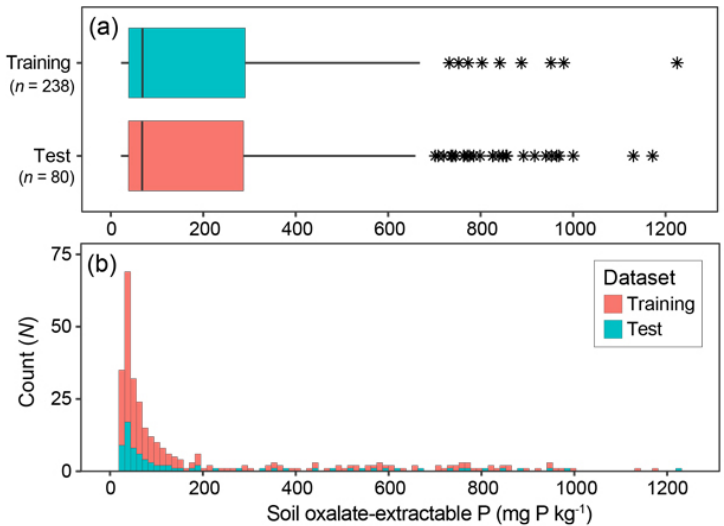
Table 2. Summary statistics of soil oxalate-extractable P data.